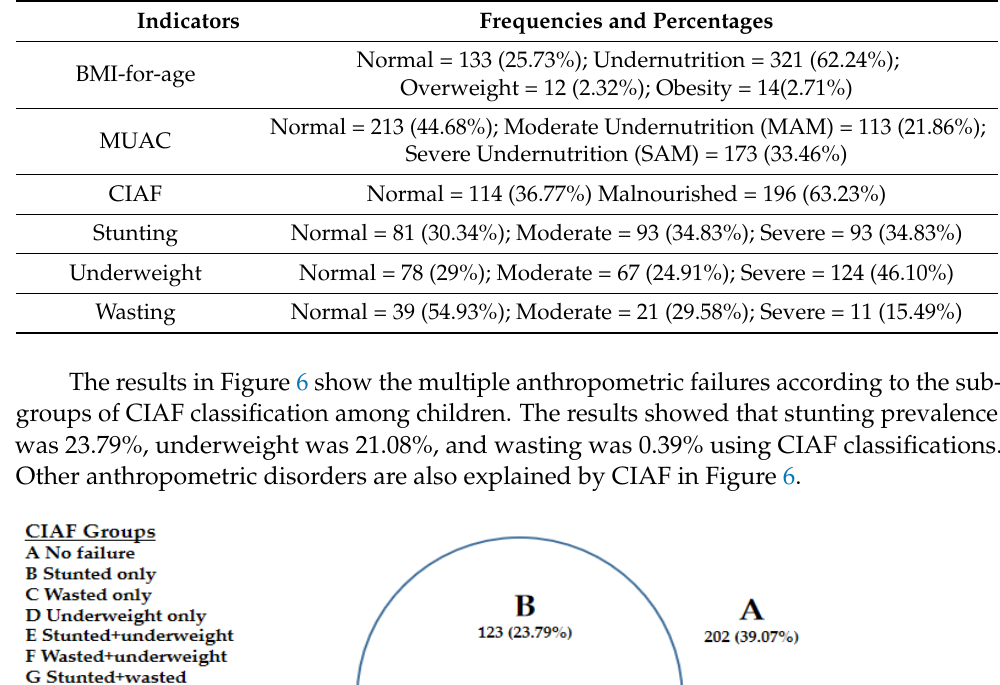
Table 4. Binary logistic regression analysis results for CIAF, MUAC, Child BMI-for-age, Conven- tional Indices, and their correlates.